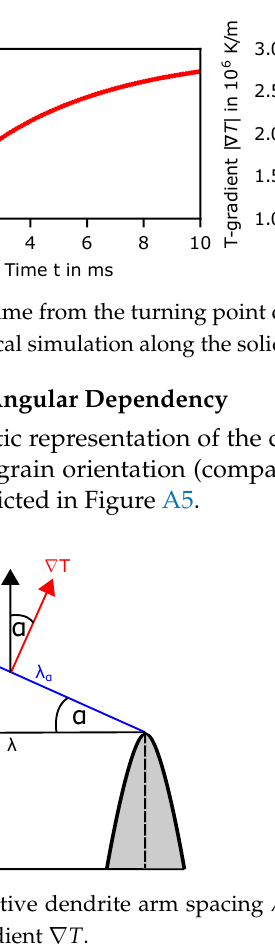
Figure A3. The time from the turning point over the ( a ) liquidus position and ( b ) liquidus velocity found in numerical simulation along the solidification pathway defined in Figure A2.